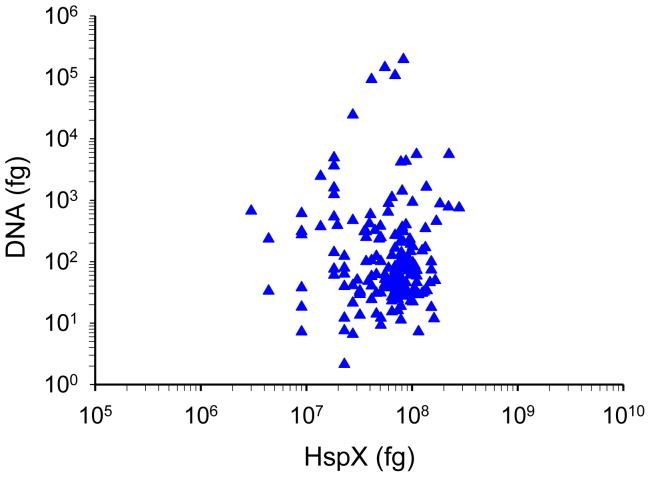
Comparison of M. tb DNA vs. antigen amount in CSF.A representative graph of HspX is shown. All other antigens showed a similar pattern (Figure S3). Starting amounts of DNA and antigen in 5 µl CSF were quantitated by qPCR and ELISA, respectively.